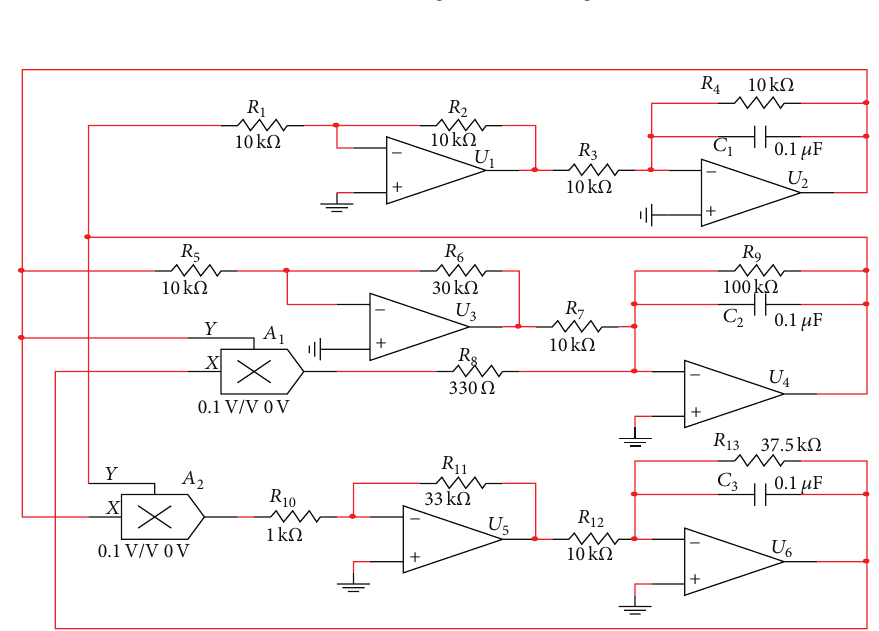
Figure 7: The final optimization